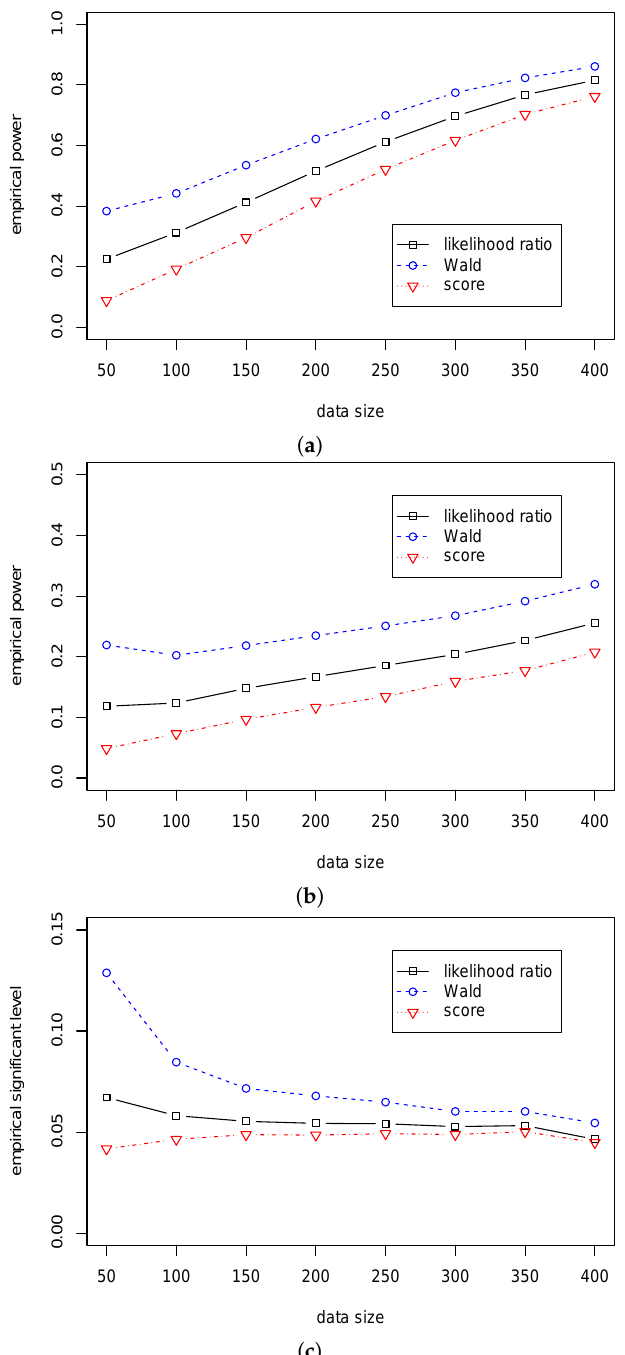
Figure 6. The empirical powers/level of three test statistics ( T L , T W , T S ) for testing H 0 : β 1 = β 2 = β 3 = 0 in Case (B3) for different α . ( a ) The empirical power with H 1 : β = ( 1, − 1,1, − 0.5 ) (cid:62) for α = 0.9; ( b ) The empirical power with H 1 : β = ( 1, − 1,1, − 0.5 ) (cid:62) for α = 0.95; ( c ) The empirical significant level with H 1 : β = ( 1, − 1,1, − 0.5 ) (cid:62) for α =